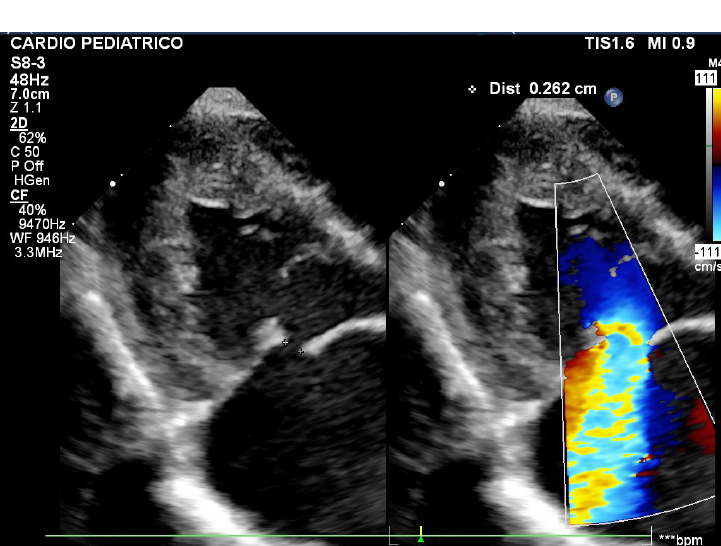
Fig. 1 - Cross-sectional echocardiography showing a perforation in the anterior leaflet of the mitral valve